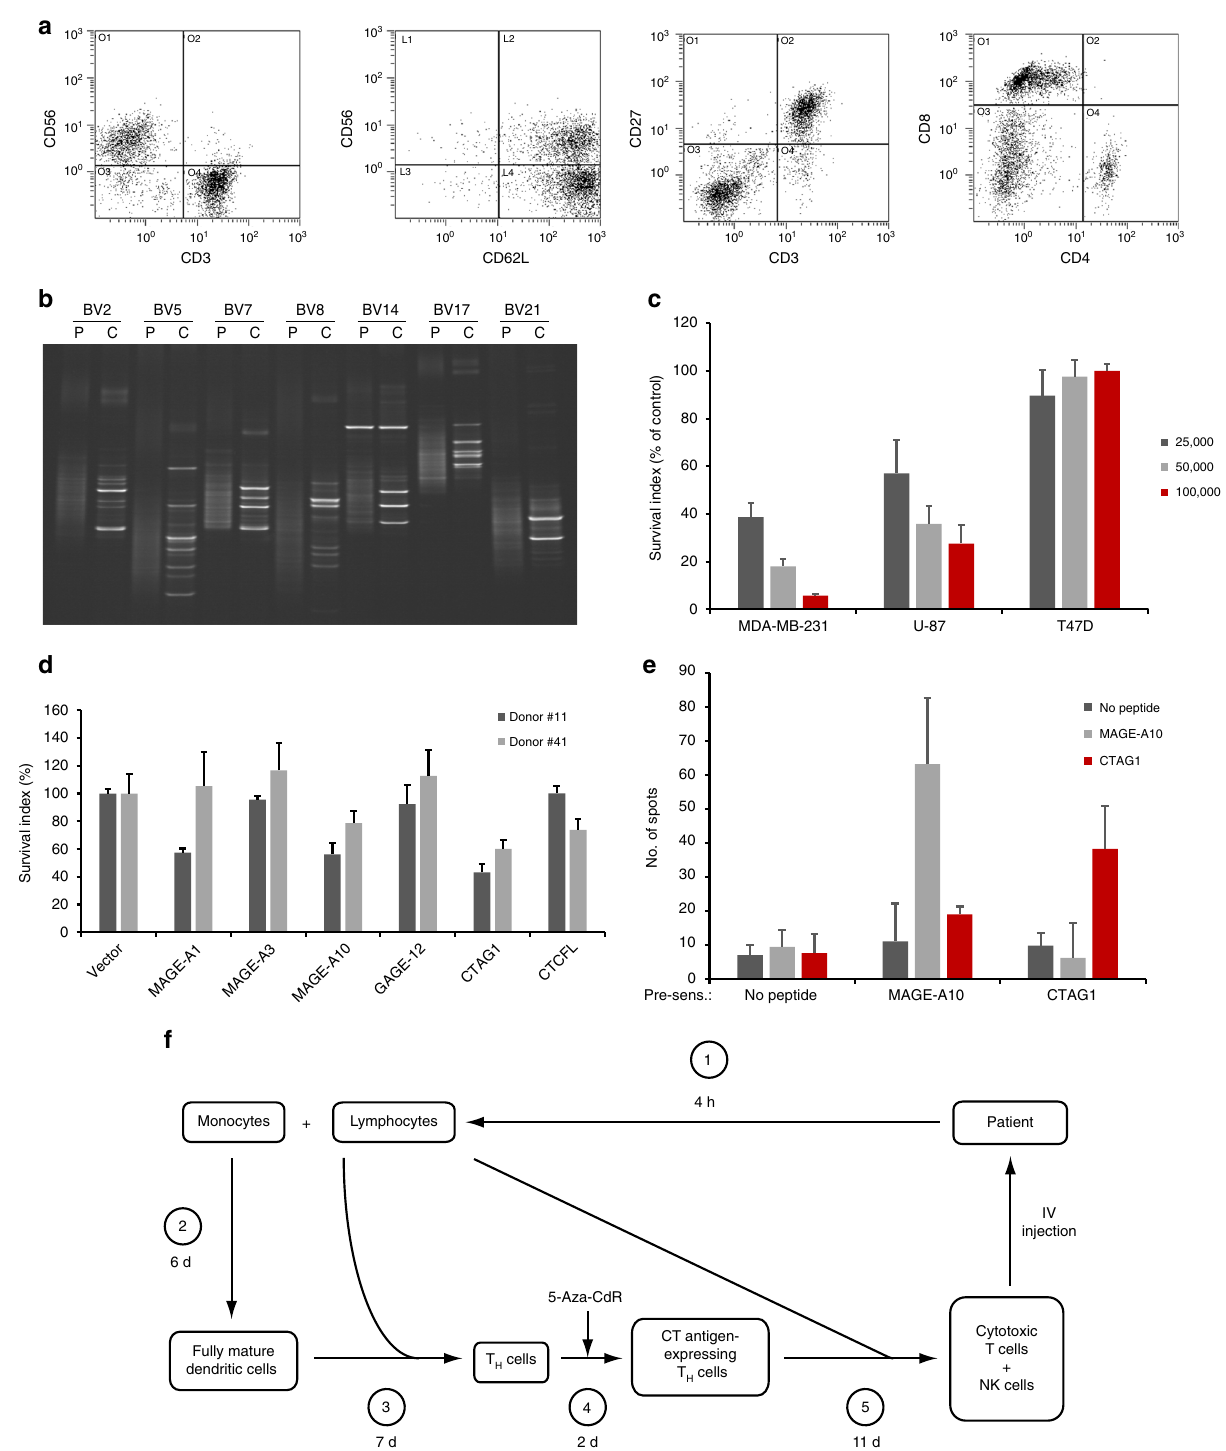
Fig. 3 Generation of tumor-reactive lymphocytes by incubation of PBLs with DNA-demethylated T H cells. a Flow-cytometric analysis of lymphocytes generated by incubation of PBLs from a healthy donor with autologous DC-induced, 5-aza-CdR-treated lymphocytes for 11 days. b TCR clonotype mapping for comparative analysis of clonotypic T cells in untreated PBLs (P) and CTLs (C) from the same donor. c Dose-dependent killing of breast cancer and glioblastoma cells. MDA-MB-231 breast cancer (HLA-A2 + ), U-87 glioblastoma (HLA-A2 + ), and T47D breast cancer (HLA-A2 − ) cells were incubated for 24 h with different numbers of cytotoxic lymphocytes prepared from a HLA-A2 + donor and quantit fi ed using the SRB assay. Data of triplicates are represented as means ± s.d. d Lysis of MEL-ST cells expressing single CT antigens by CD56-depleted cytotoxic lymphocytes. Representative results are shown for two of fi ve healthy donors tested. Data of triplicates are represented as means ± s.d. e ELISPOT analysis. Cells were presensitized with peptides and dendritic cells for 7 days, as indicated. For ELISPOT assays, 5 × 10 4 cells per well were seeded in the presence or absence of peptides, and analysis was performed with fi ve replicates. f Diagram showing the procedure for generation of cytotoxic lymphocytes used in the clinical